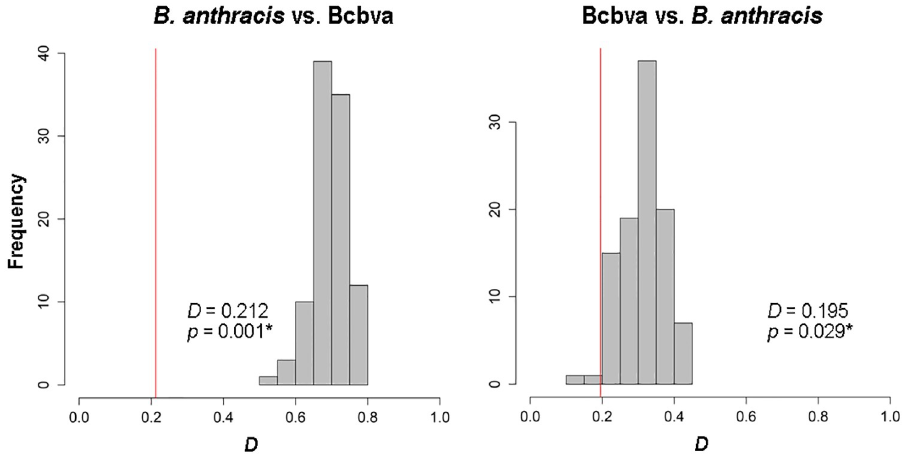
Fig 4. Background similarity test between Bacillus anthracis and Bcbva using all environments in geographic space. The comparison was done using all variables (i.e., 12 PCs) and calculating Schoener’s D statistic. Significant p - values (asterisk) indicate less similarity than expected when comparing to a random